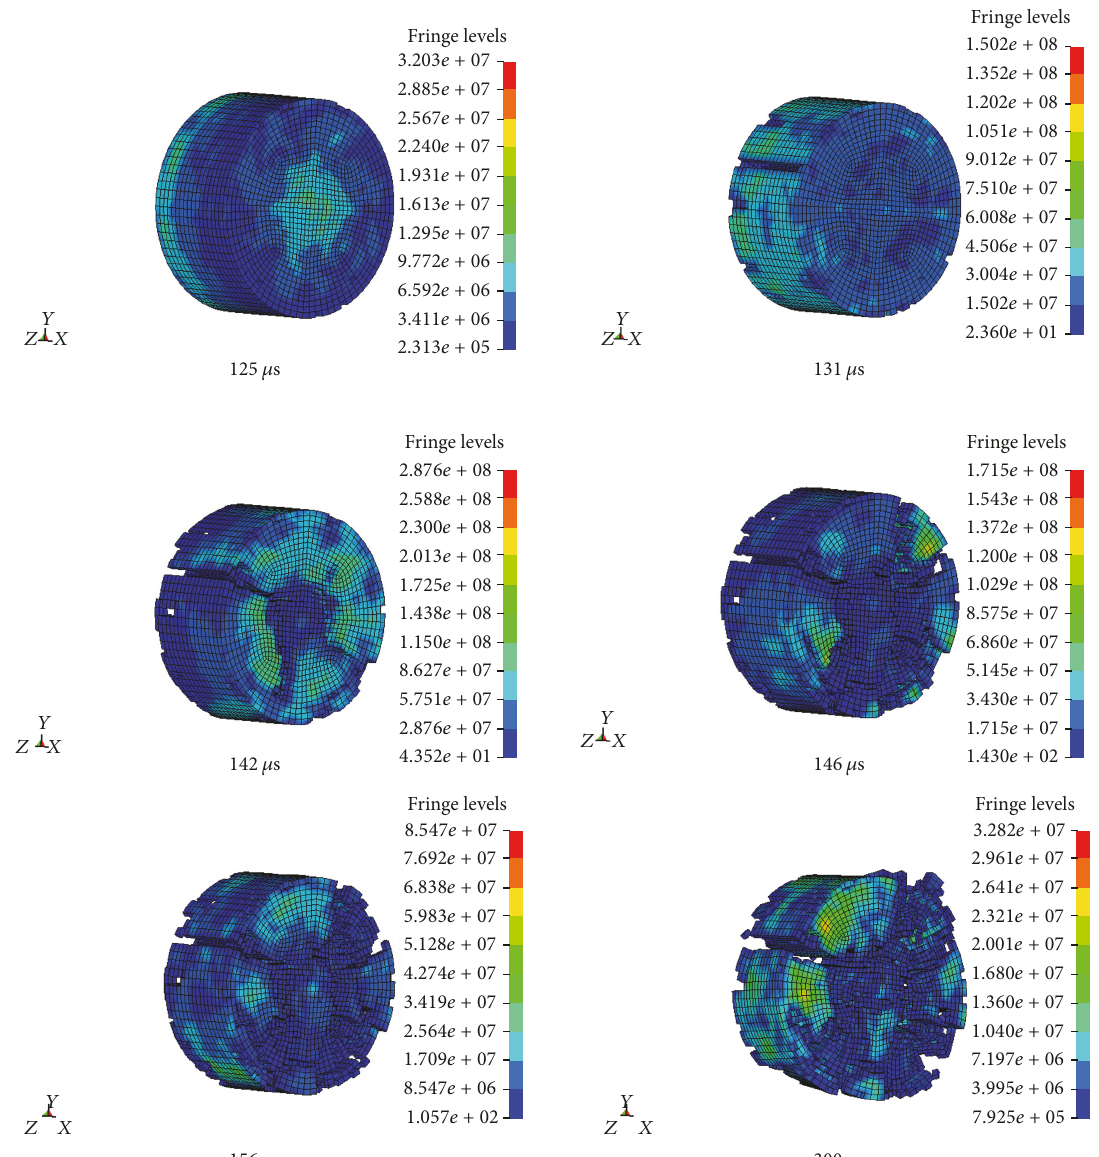
Figure 12: Numerical fracture process (the average strain rate is 52 s −1